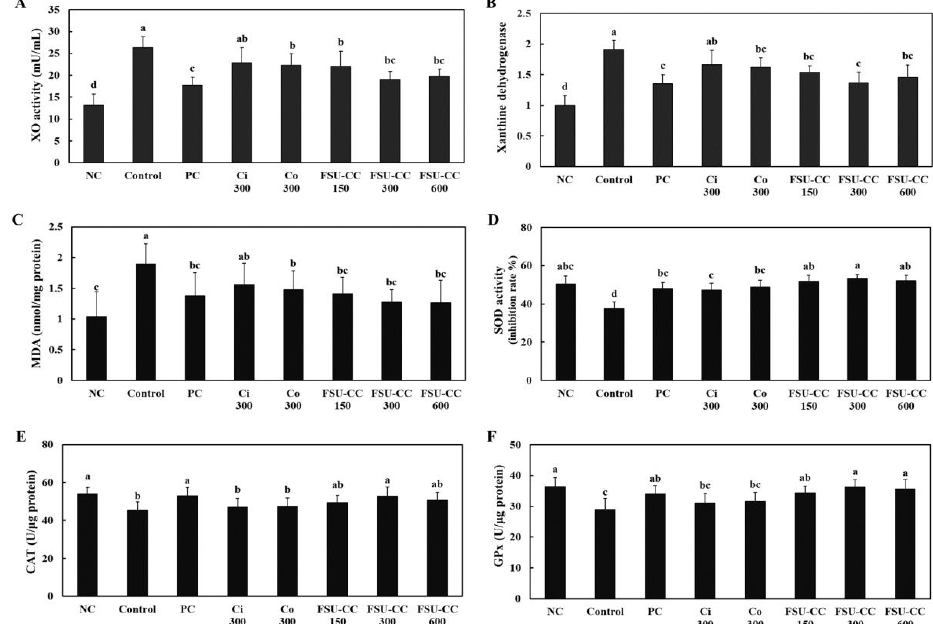
Figure 5. Xanthine oxidase activity ( A ); xanthine dehydrogenase mRNA expression ( B ); malondialdehyde (MDA) levels ( C ); and activities of superoxide dismutase (SOD) ( D ), catalase (CAT) ( E ), and glutathione peroxidase (GPx) ( F ) in the liver from hyperuricemia-induced mice supplemented with and without Ci, Co, or FSU-CC. NC: normal control, C: hyperuricemia-induced mice, PC: hyperuricemia-induced mice with oral supplementation of allopurinol 10 mg/kg b.w., Ci 300: hyperuricemia-induced mice with oral supplementation of C. indicum L. 300 mg/kg b.w., Co 300: hyperuricemia-induced mice with oral supplementation of C. officinalis Siebold and Zucc. 300 mg/kg b.w., FSU-CC 150: hyperuricemia-induced mice with oral supplementation of mixture of C. indicum L. and C. officinalis Siebold and Zucc. (1:2) 150 mg/kg b.w., FSU-CC 300: hyperuricemia-induced mice with oral supplementation of mixture of C. indicum L. and C. officinalis Siebold and Zucc. (1:2) 300 mg/kg b.w., FSU- CC 600: hyperuricemia-induced mice with oral supplementation of mixture of C. indicum L. and C. officinalis Siebold and Zucc. (1:2) 600 mg/kg b.w. Different letters indicate significant difference at p < 0.05, as determined by Duncan’s multiple range